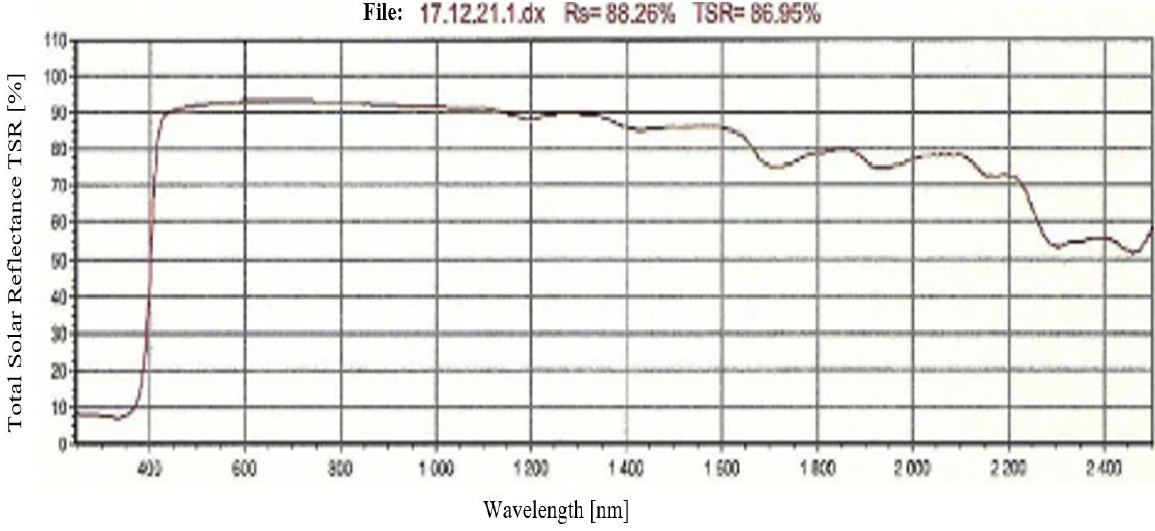
Figure 2. Dependence of solar reflectance TSR for white heat reflective paint as a function of wavelength (in the range 250–2500 nm) [29].